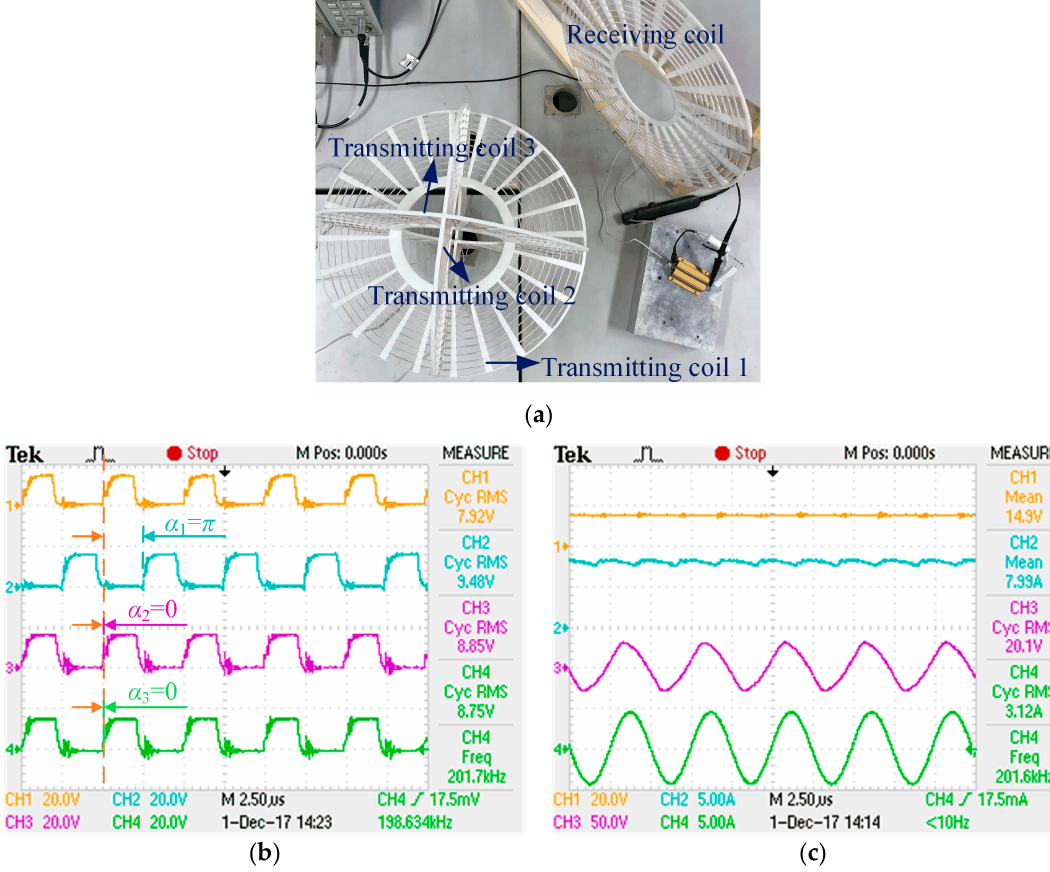
Figure 15. Practical measurements in the conditions Θ = 90°, Φ = 45°, θ ′ = 0°, φ ′ = 90°, ψ ′ = 45° and d = 0.4 m. ( a ) Locations and postures of system coils; ( b ) phase-shifted drive pulses; ( c ) input/output voltage and current waveforms.